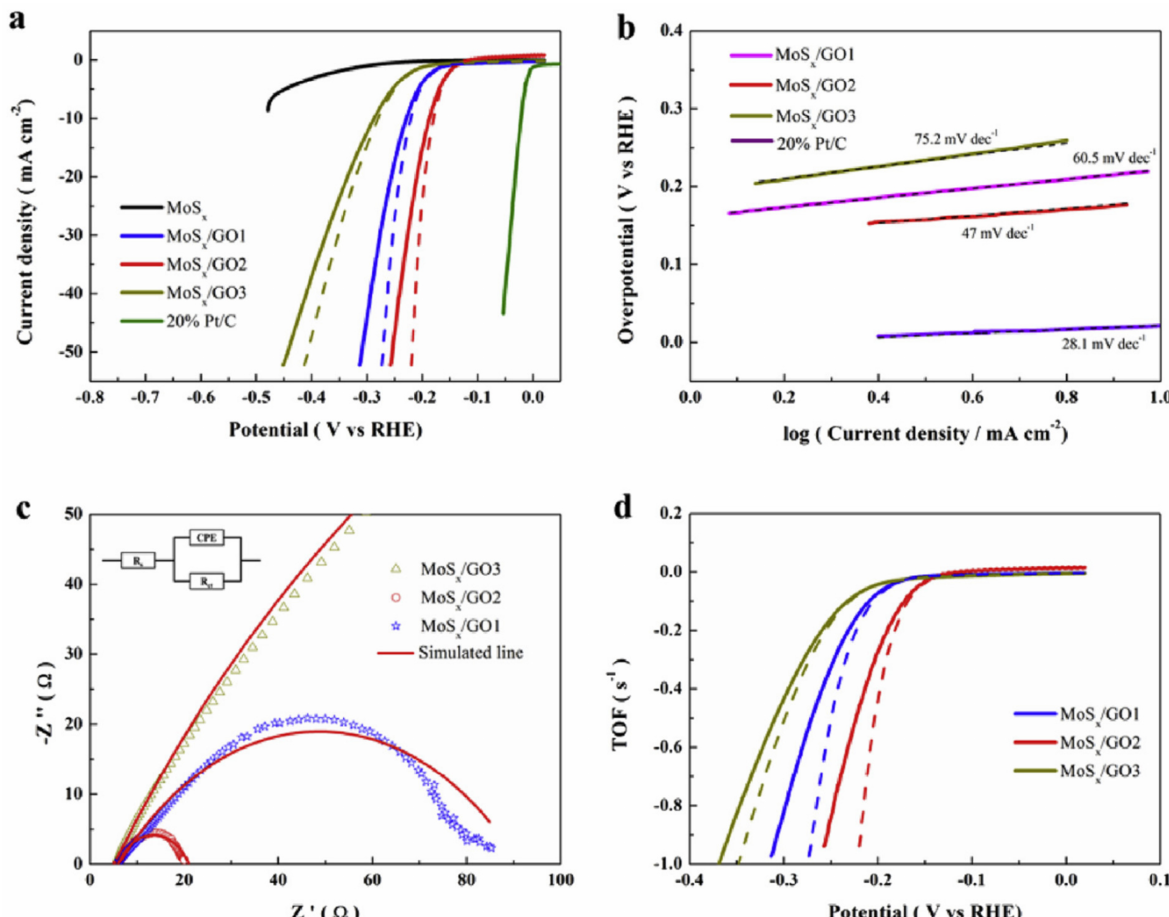
Figure 16. ( a ) Linear sweep voltammogram curves in 0.5M H 2 SO 4 for different MoS x /GO electrocat- alysts; ( b ) Tafel plots of different MoS x /GO electrocatalysts; ( c ) AC impedance spectra for different MoS x /GO electrocatalysts; ( d ) Calculated turnover frequencies of different MoS x /GO electrocatalysts, the dashed line is the TOF curve with iR correction. (Reprinted with permission from reference [166]. Copyright 2016,